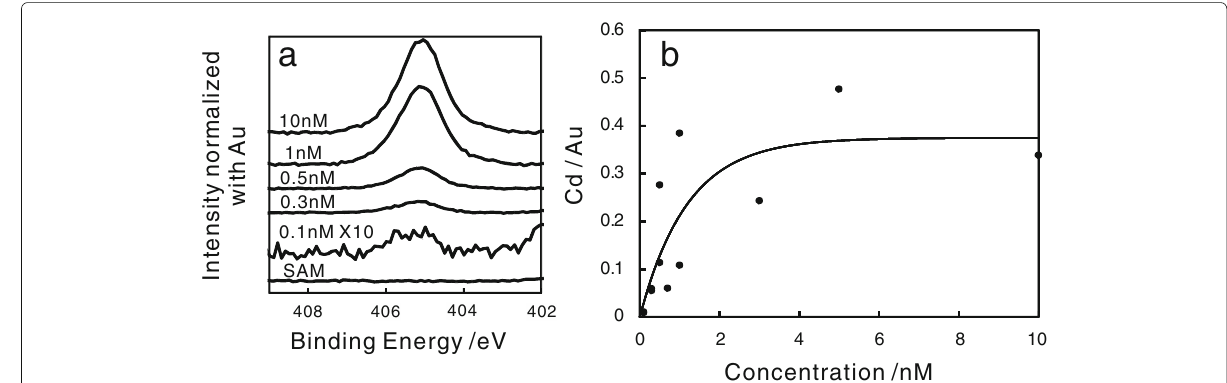
Fig. 1 a XPS spectra of the substrates with/without QDs. b Atomic ratio of Cd/Au as a function of the concentration of QD solution